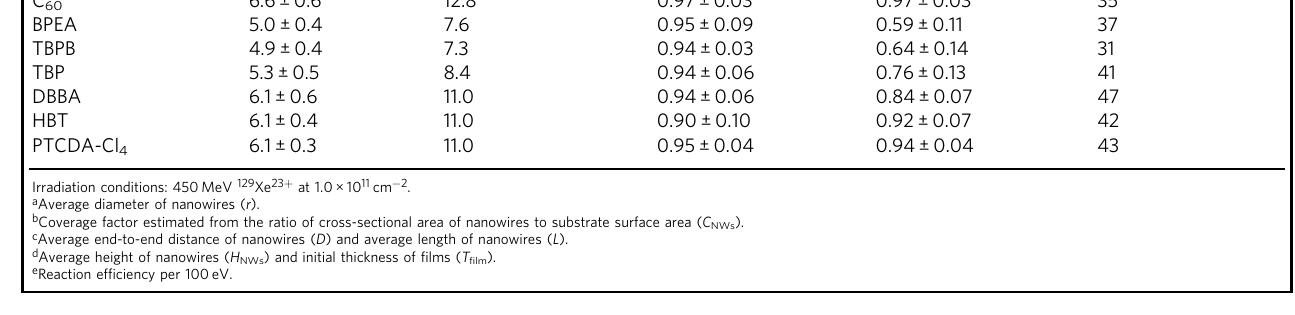
Table 1 Comparison of various parameters of nanowires obtained from sublimable organic small-molecule materials.